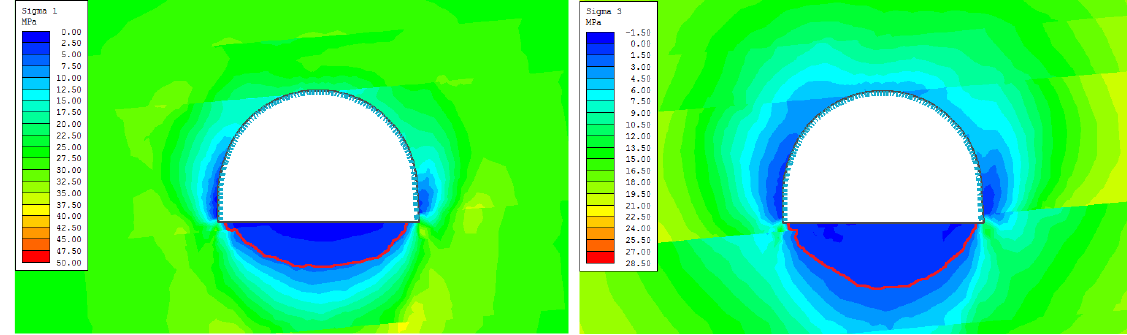
Figure 23. Extent of the failure zone beneath the waterlogged floor of roadway D-2 — stage 3.